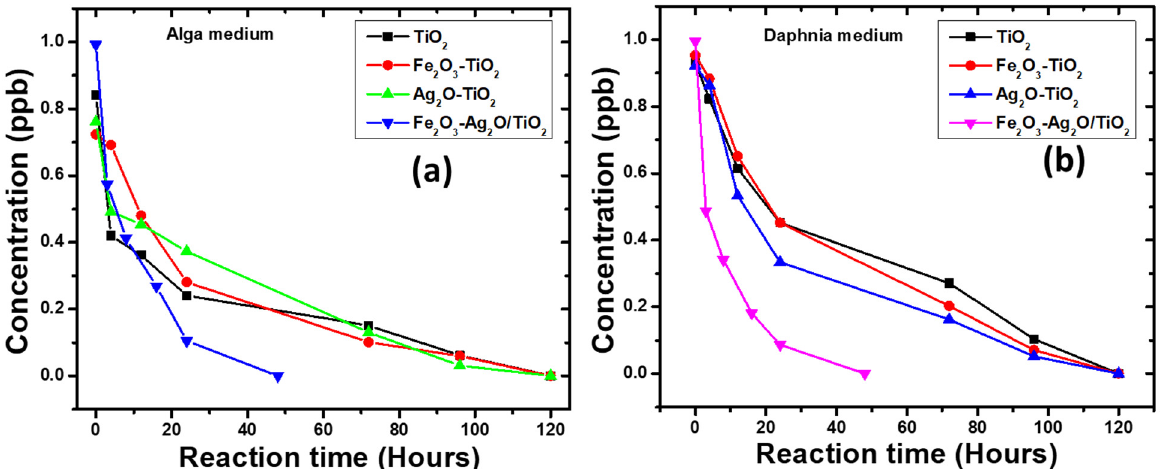
Figure 7. The dissipation curve of photocatalytic decontamination of Spiromesifen in alga ( a ) and daphnia ( b ) media under direct sunlight with TiO 2, Fe 2 O 3 -TiO 2 , Ag 2 O-TiO 2 , and Fe 2 O 3 -Ag 2 O/TiO 2 nanocomposites.